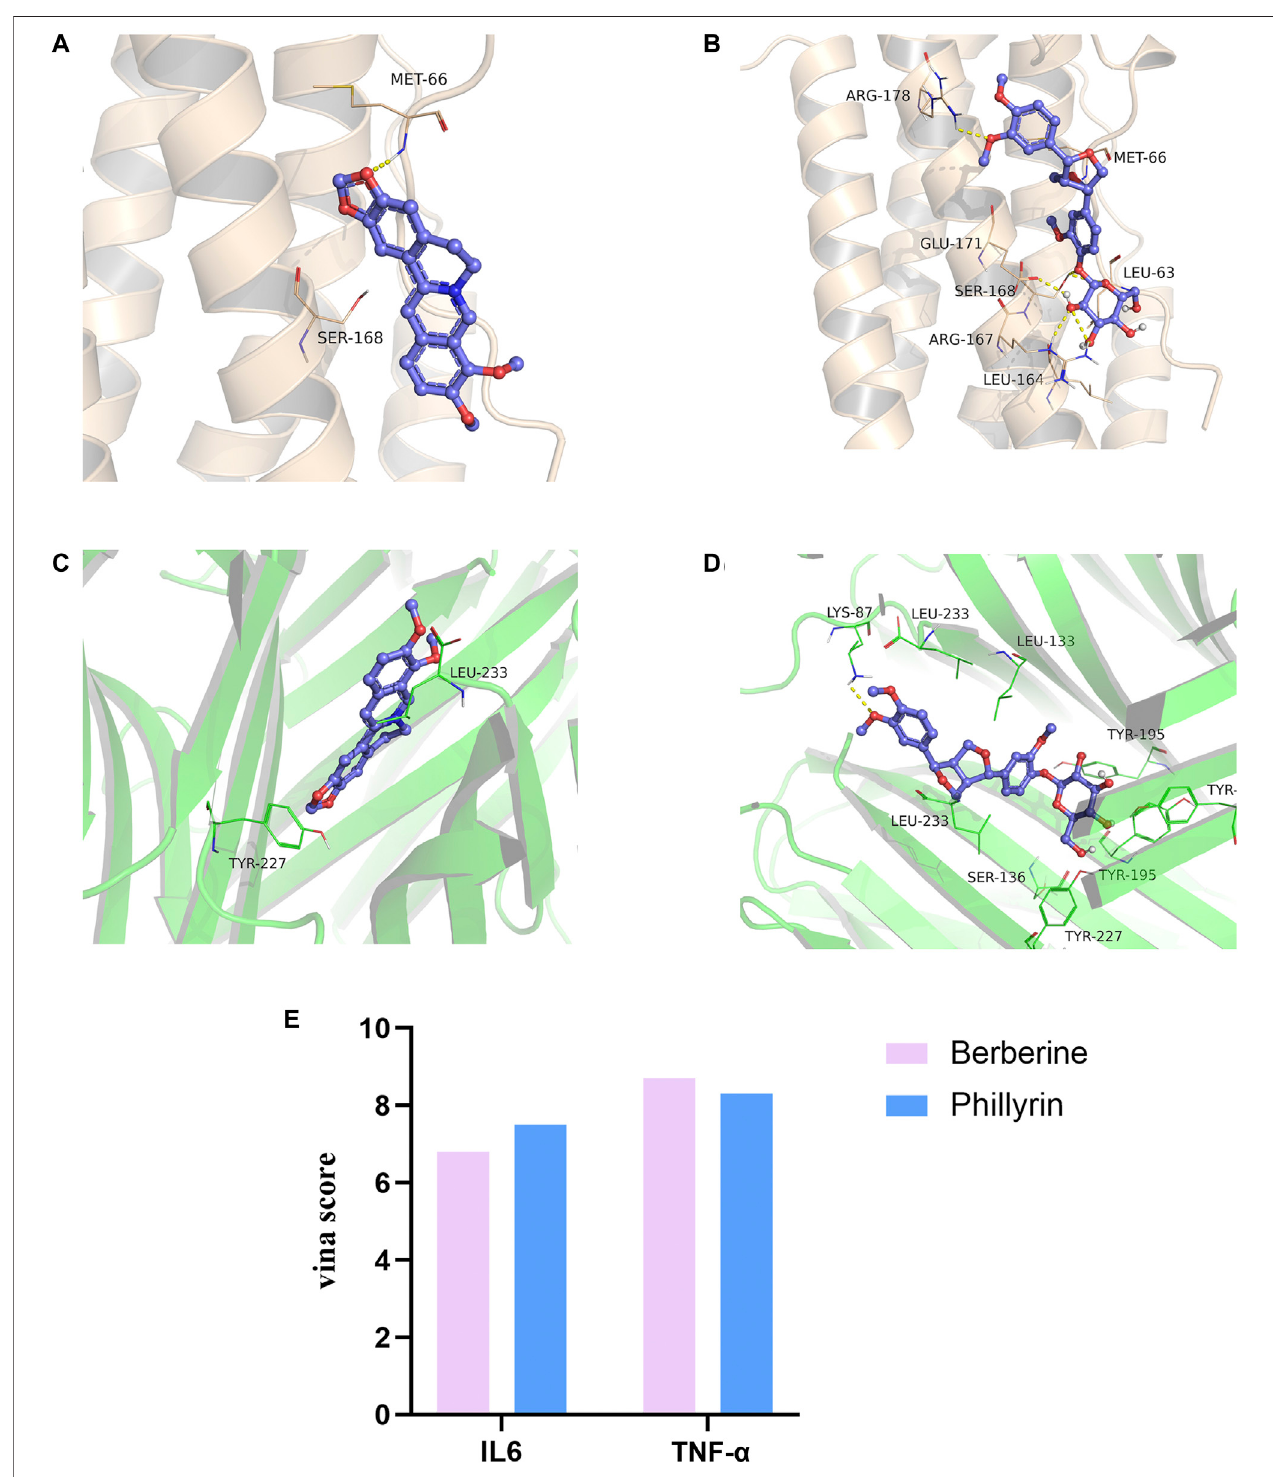
FIGURE 5 | Molecular docking. (A) Berberine-(IL-6). (B) Phillyrin-(IL-6). (C) Berberine-(TNF- α ). (D) Phillyrin-(TNF- α ). (E) Absolute value of vina score (kcal/mol).